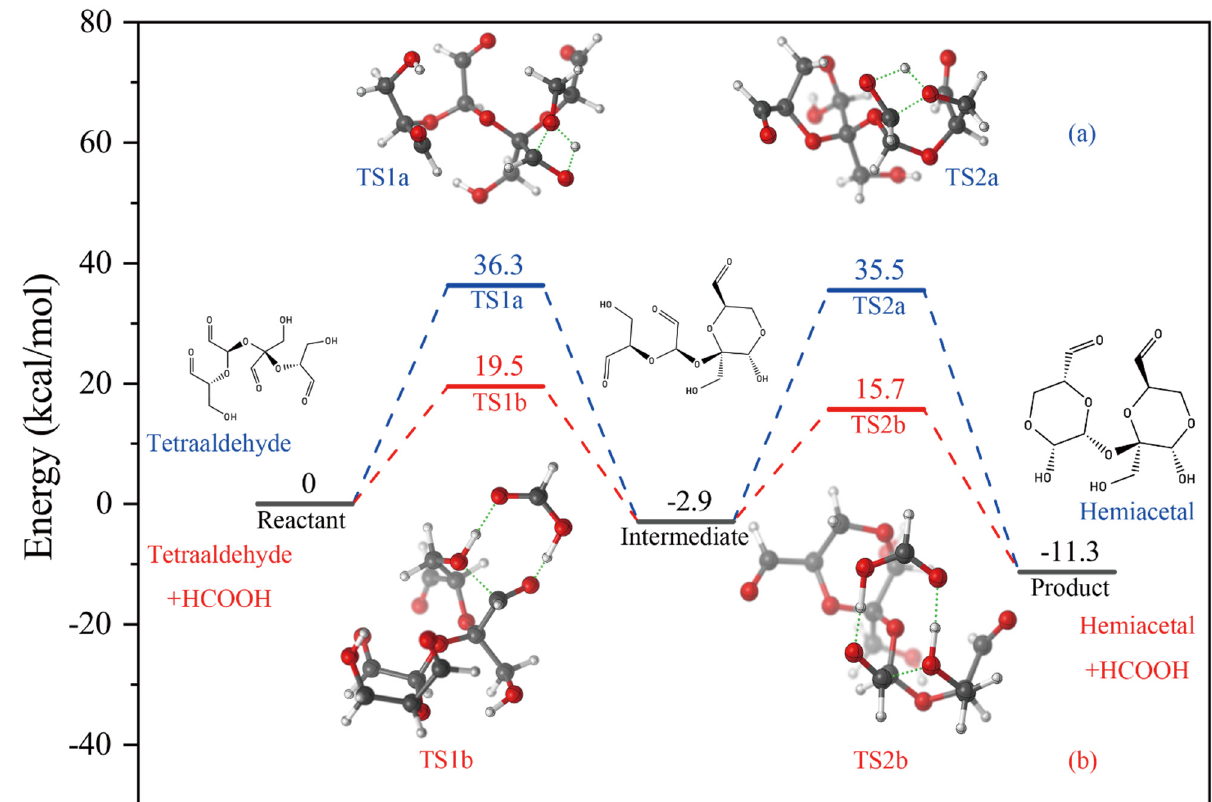
Figure 10. ( a ) Potential energy profile of oxidized sucrose forming a hemiacetal structure. ( b ) Potential energy distribution of oxidized sucrose to form hemiacetal structures assisted by formic acid.